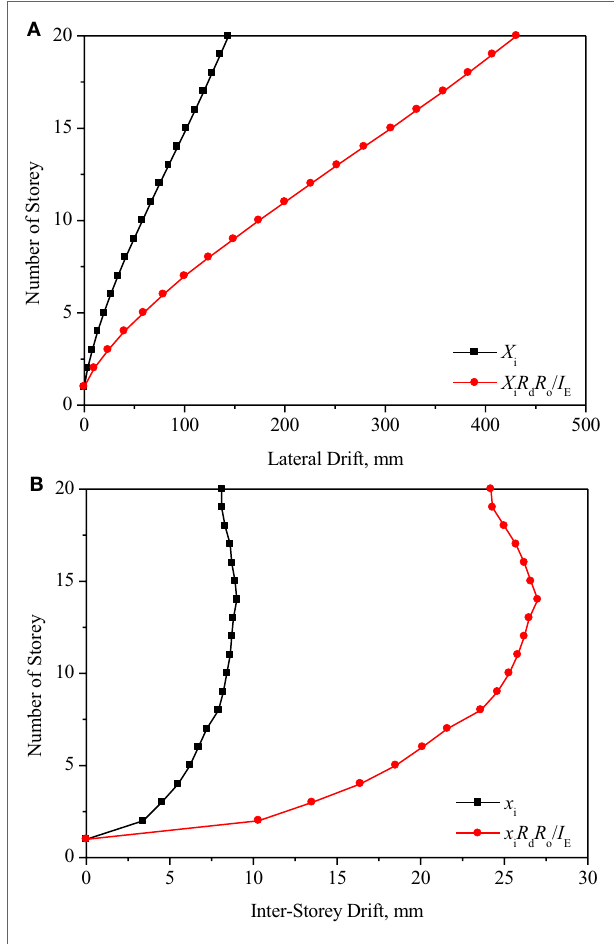
FigUre 6 | Storey drifts (a) and inter-storey drifts (B) of CHECKER building under static wind effect. FigUre 7 | Storey drift (a) and inter-storey drift (B) of CHECKER building under earthquake using response spectrum analysis.